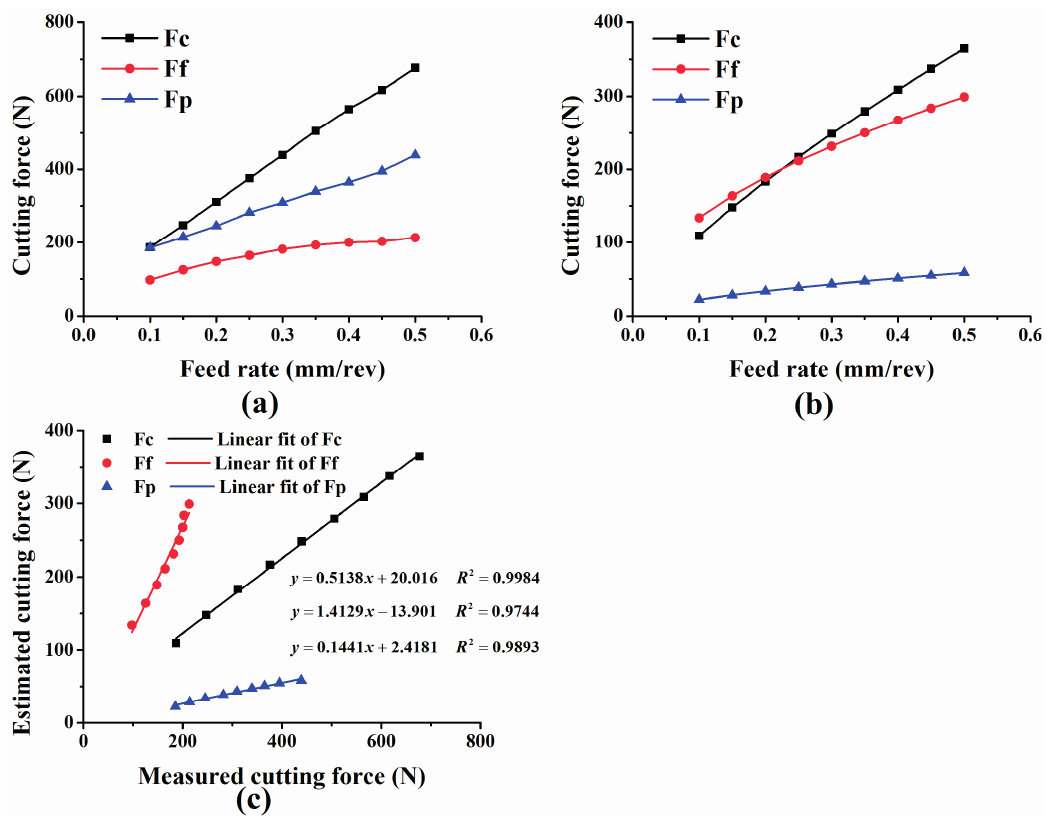
Figure 12. ( a ) Measured cutting forces in group one; ( b ) Estimated cutting forces in group one; ( c ) Correlation analysis between measured and estimated cutting